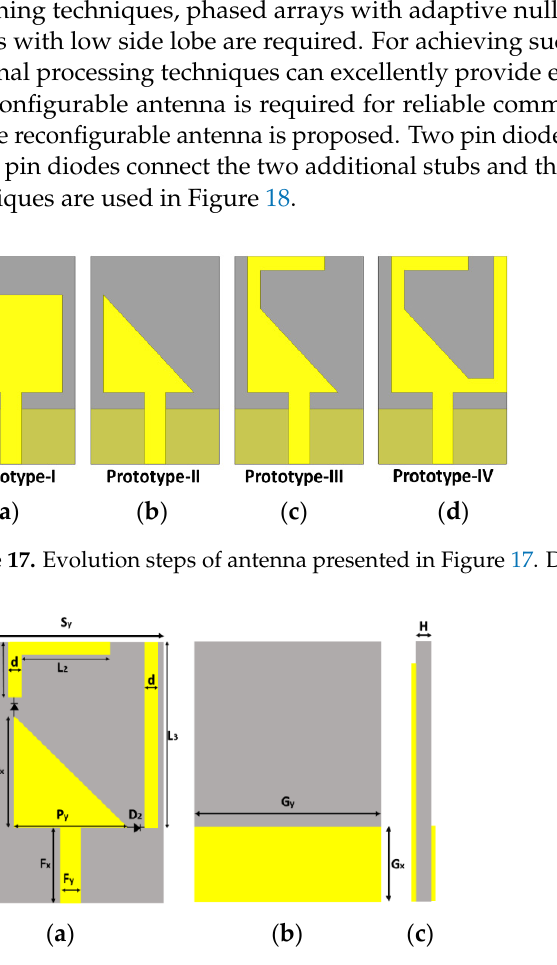
Figure 18. Final geometry of antenna element. ( a ) Top view, ( b ) bottom view, and ( c ) side view [74].